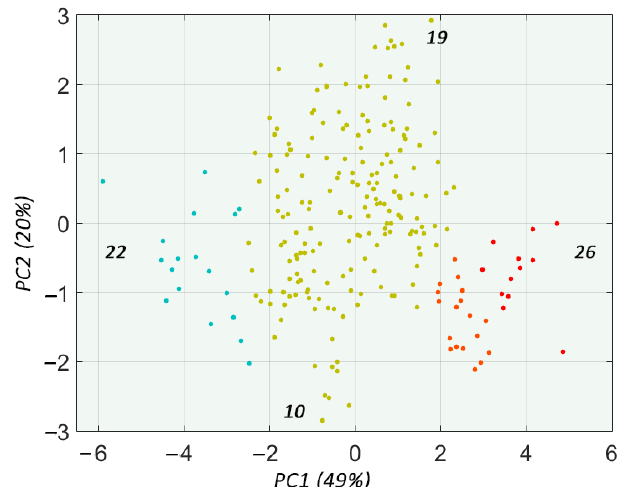
Figure 1. Principal component analysis of phenotypic traits of common bean mutant lines subjected to drought stress. The first two components explain 69% of variance between common bean lines according to length of plant, fresh weight of plant, fresh weight of fruits per plant, length of fruit per plant, width of fruit per plant, and weight of common beans after drought stress. Scores are clustered in four groups in different colours according to their distribution in the PCA score plot. Their corresponding numbers show the bean lines with the highest contribution on the positive and negative PC1 and PC2 scales,